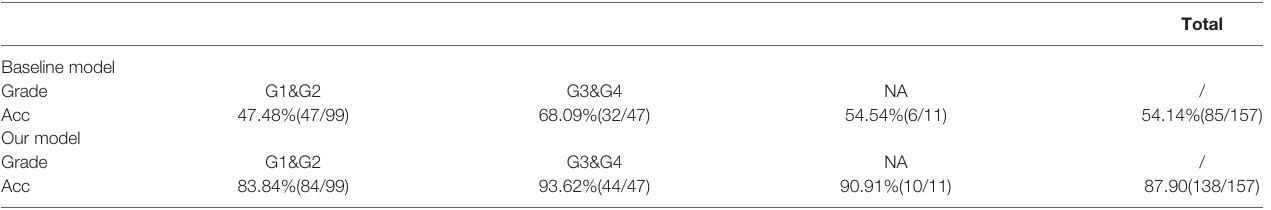
TABLE 4 | Slide-level accuracy results of different grades in The Cancer Genome Atlas